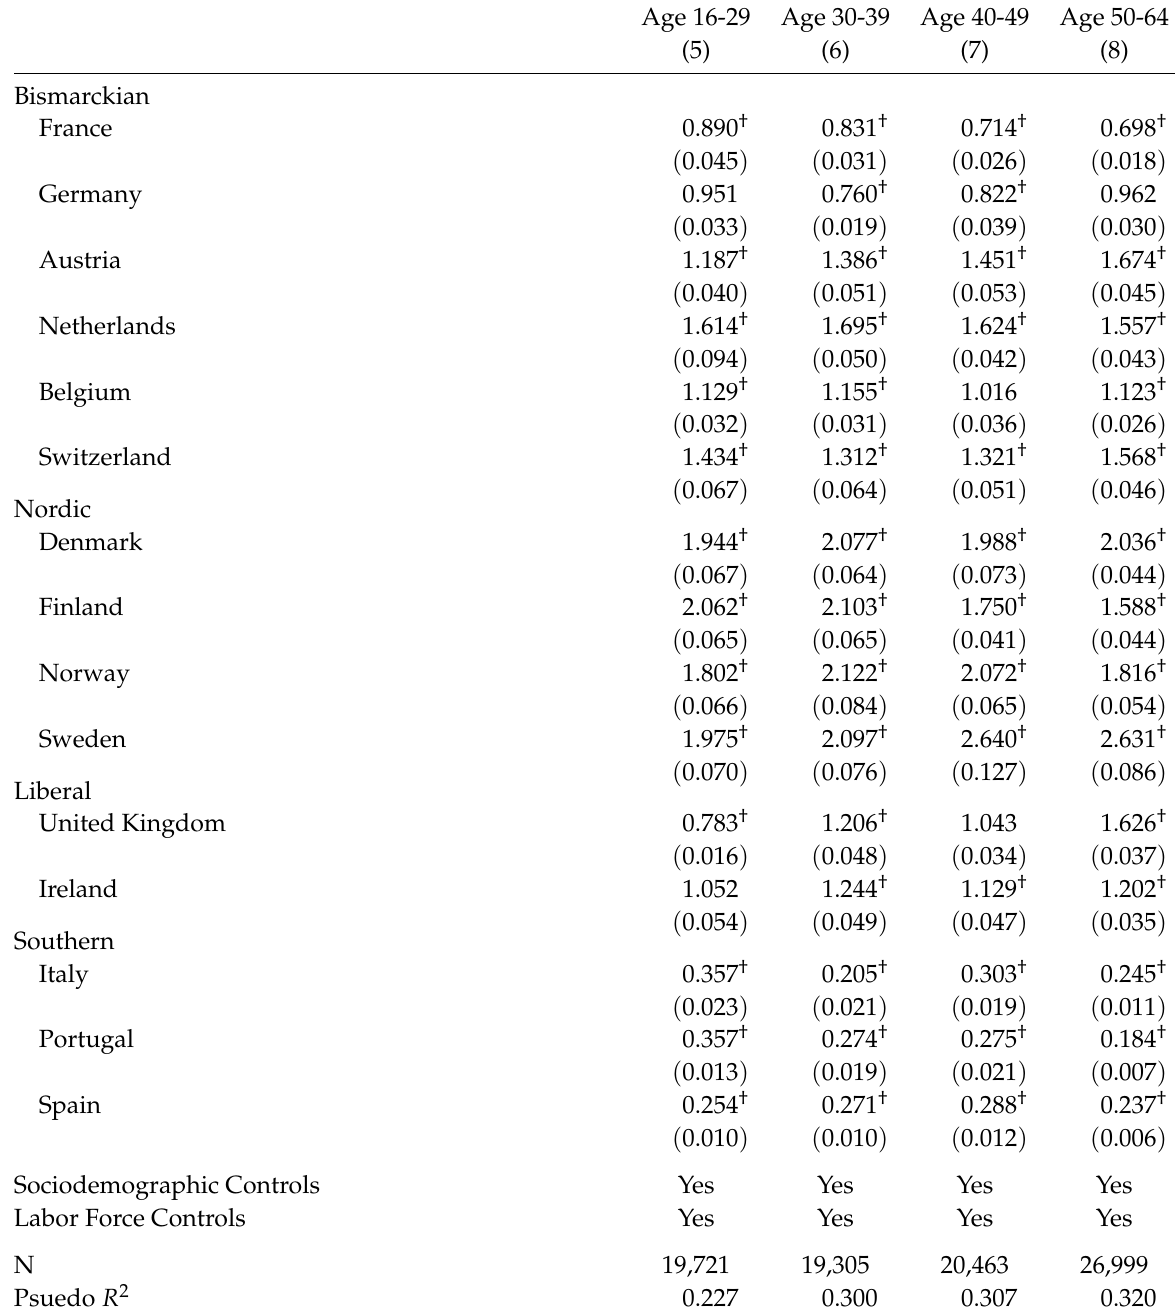
Table 3: Logistic Models Predicting Self-Reported Disability By Age and Country of